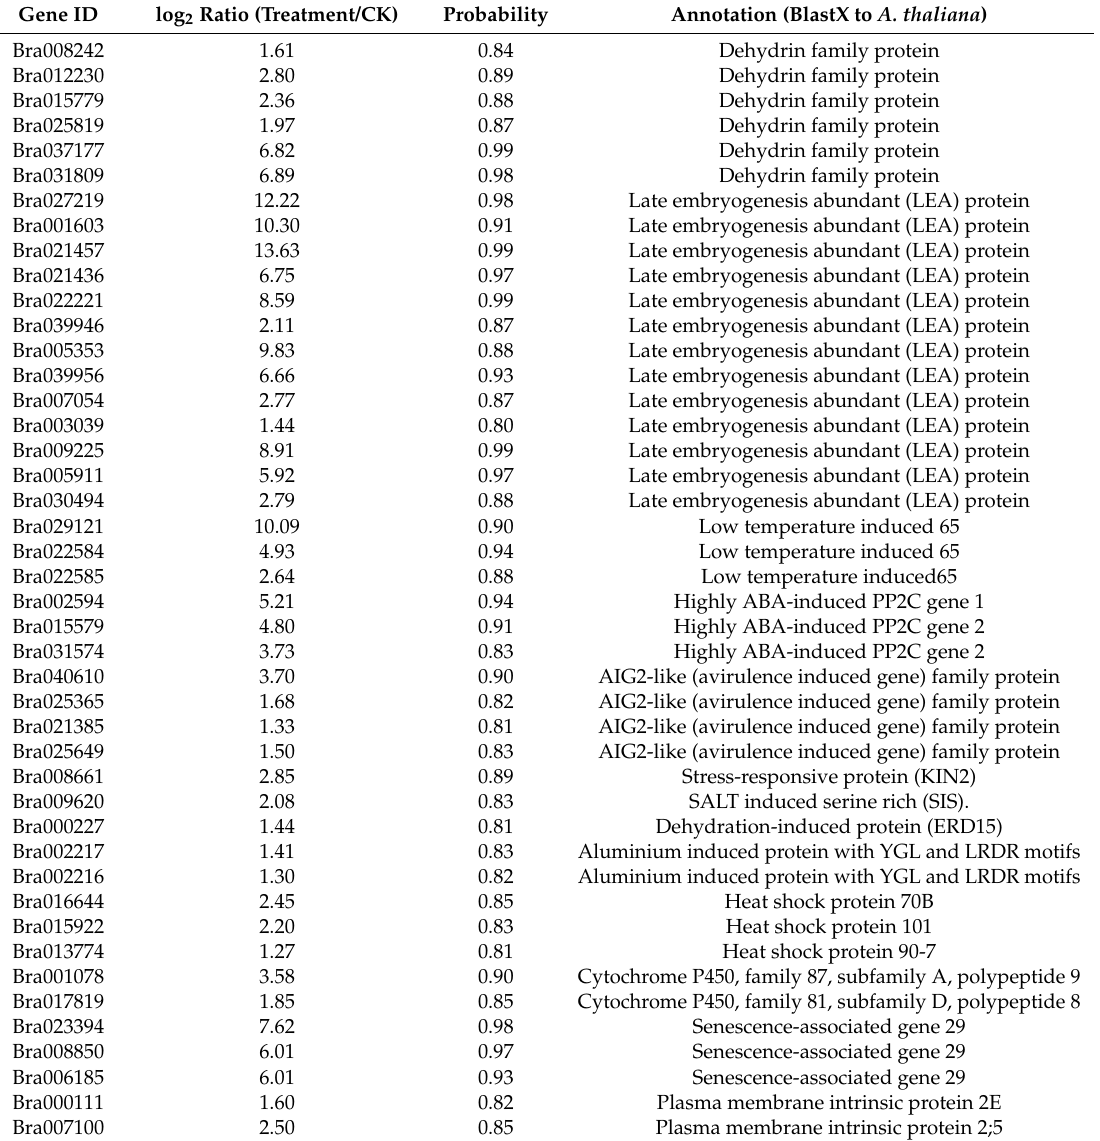
Table 6. Other up-regulated DEGs that are proposed to play important roles in the salt-stress response in Chinese